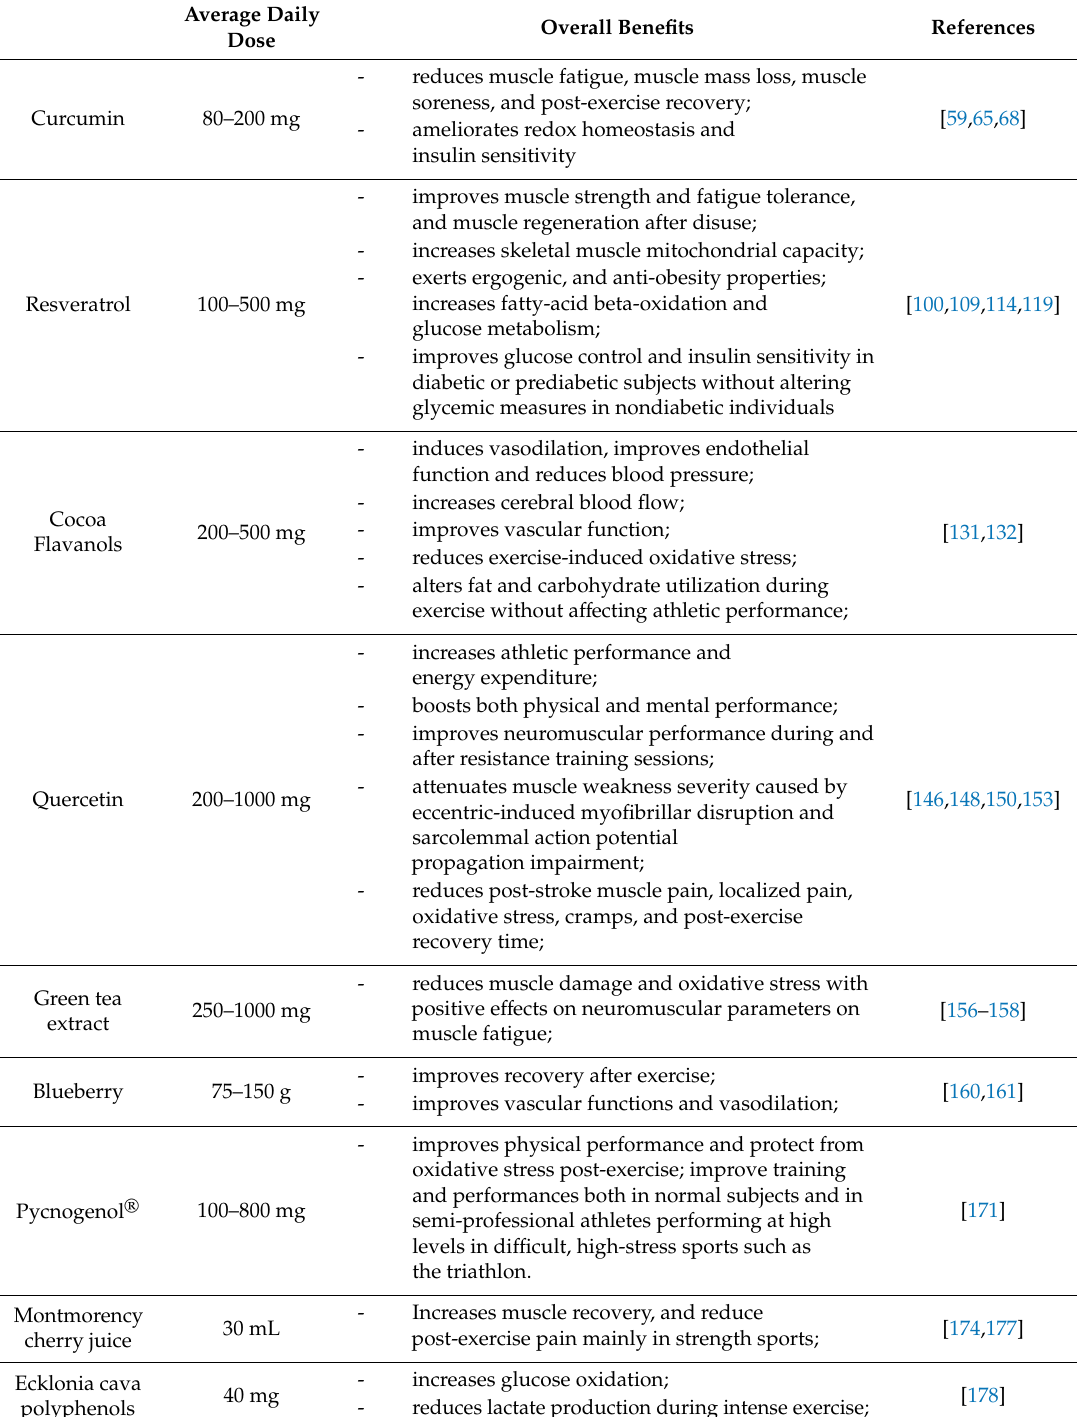
Table 1. Average daily dose and overall benefits in humans of polyphenol supplementation in sports